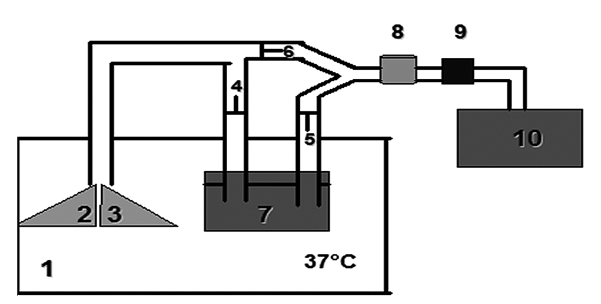
Figure 1 - Mechanical model. Components include: a large plastic box maintained at 37°C (1), preserved swine lungs (2, 3) and a cascade-type humidifier (7) inside the box. Three unidirectional valves (4, 5 and 6) were inserted within the tubing section external to the box (representing the airway) to direct flow through the humidifier prior so that it could ventilate the lungs. In this same simulated airway segment, a sensor (Vaisala, HMI 32, Woburn, MA, USA) (8) was positioned to detect AH and temperature. The HME (9) under test was individually installed using a random sequence for each testing period. A mechanical ventilator (10) was used to simulate different ventilatory conditions.